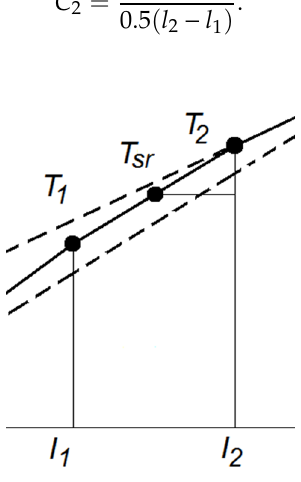
Figure 12. Principle of determining the slope coefficient of the C 2 range.